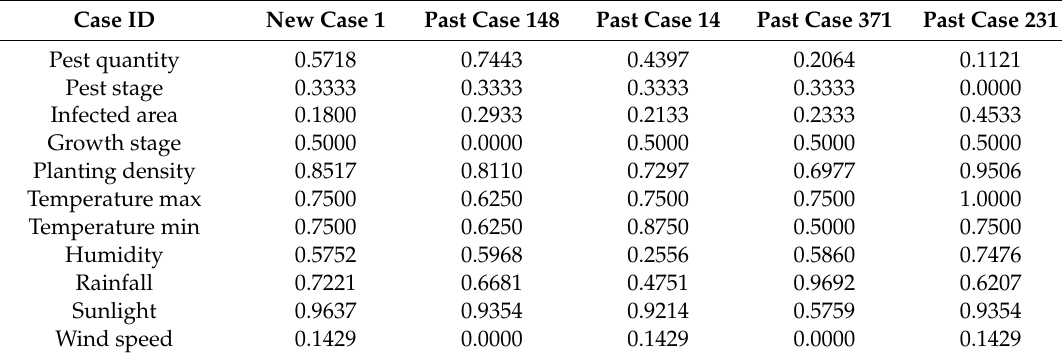
Table 3. Normalized attributes of new case 1, past case 148, 14, 371, and 231.